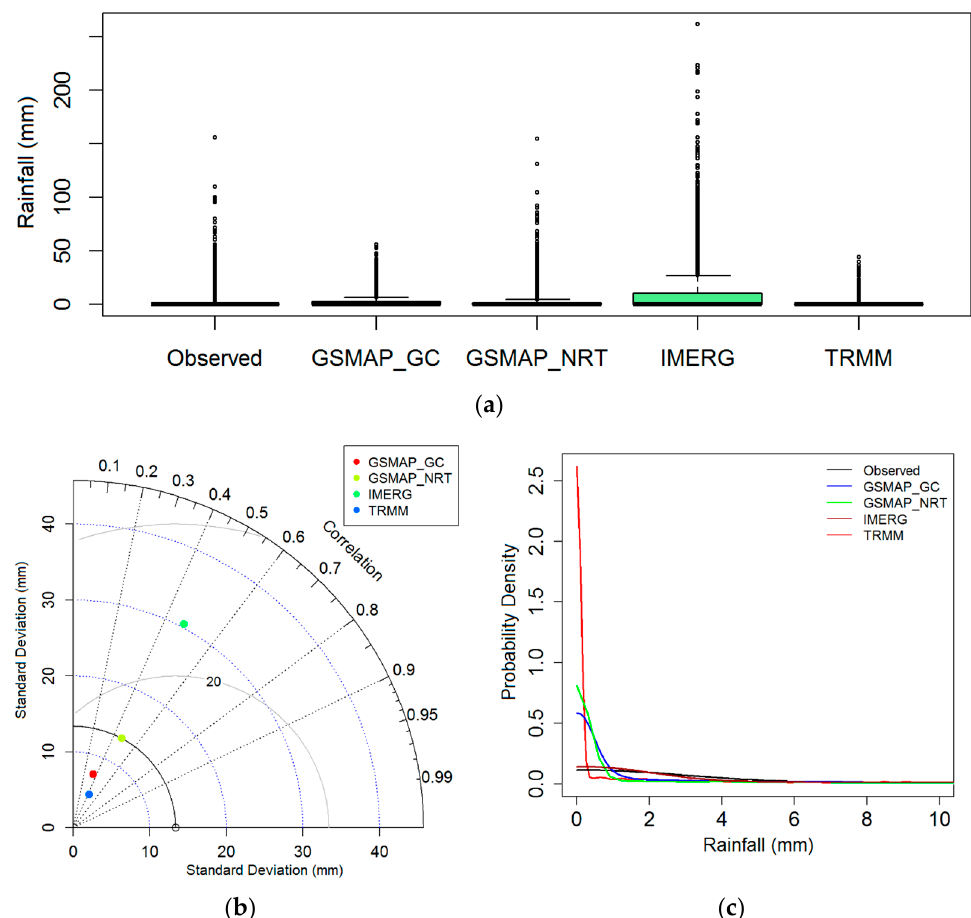
Figure 3. ( a ) Box plot; ( b ) Taylor diagram; ( c ) density plot of observed and satellite daily rainfall during 2015–2018.